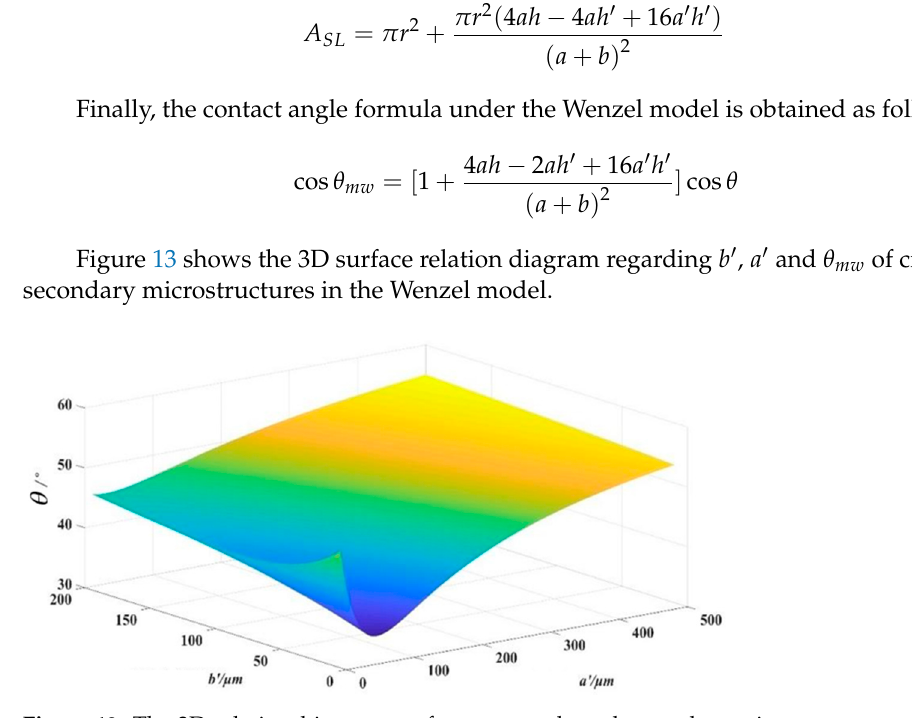
Figure 13. The 3D relationship curves of contact angle and secondary microstructure parameters under the Wenzel model.